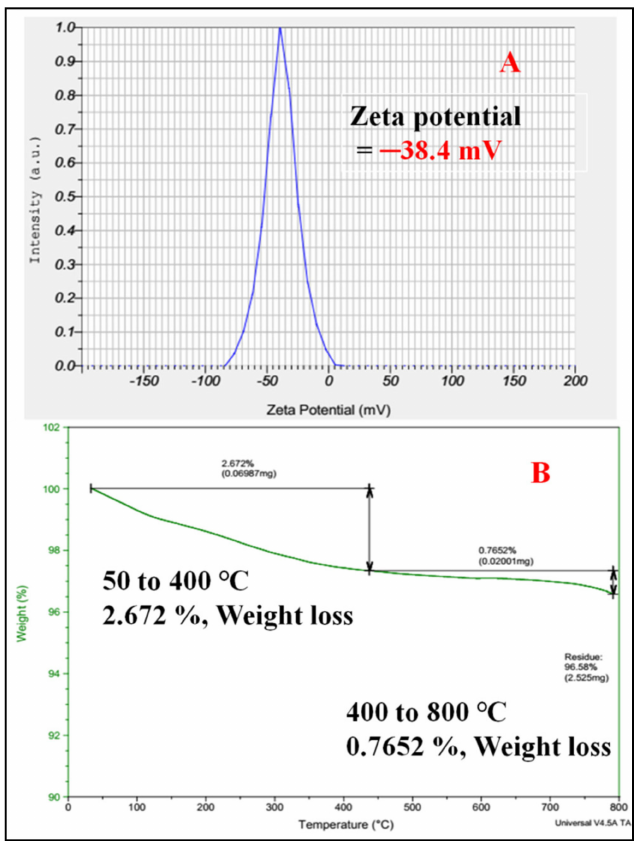
Figure 7. Stability analysis of ZnO-NPs: ( A ) colloidal stability; ( B ) thermal